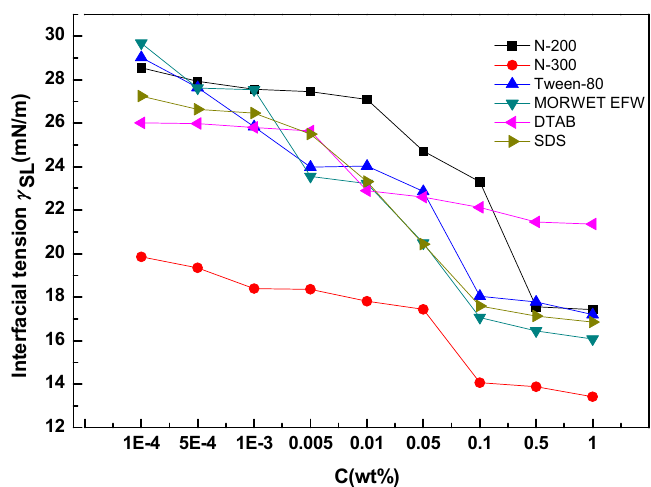
Figure 7. Relationship between interfacial tension ( γ SL ) and surfactant concentrations. Table 4. Slope and coefficient values obtained by the relationship between the surface tension and adhesion tension.